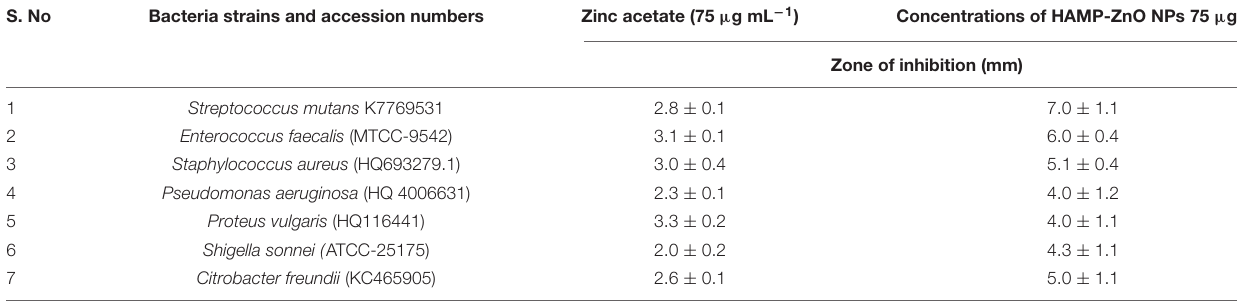
TABLE 2 | The inhibition zones (mm) of Zinc acetate (control) and HAMP-ZnO NPs against pathogenic bacteria are detailed. S. No